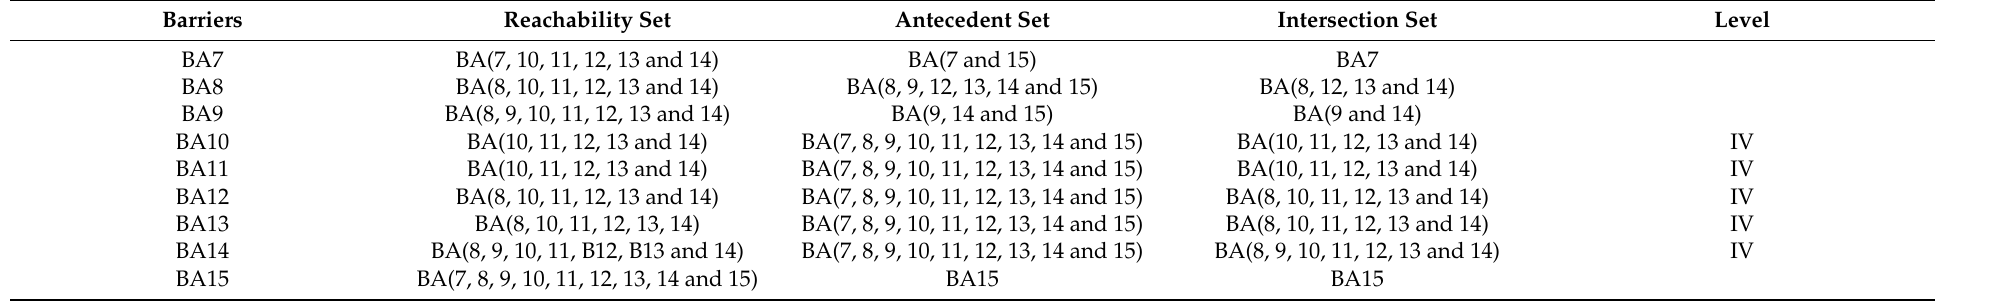
Table 12. Level IV partition of the hierarchical structure of the barriers using a final reachability